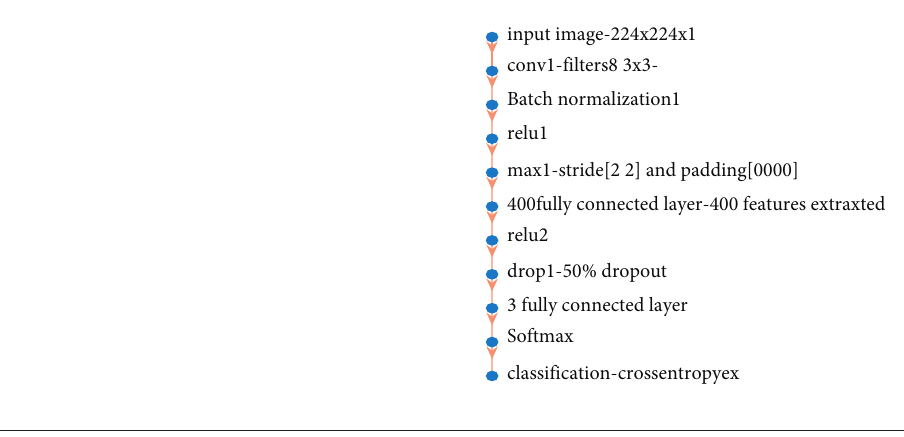
Figure 3: The proposed model layers’ structure.